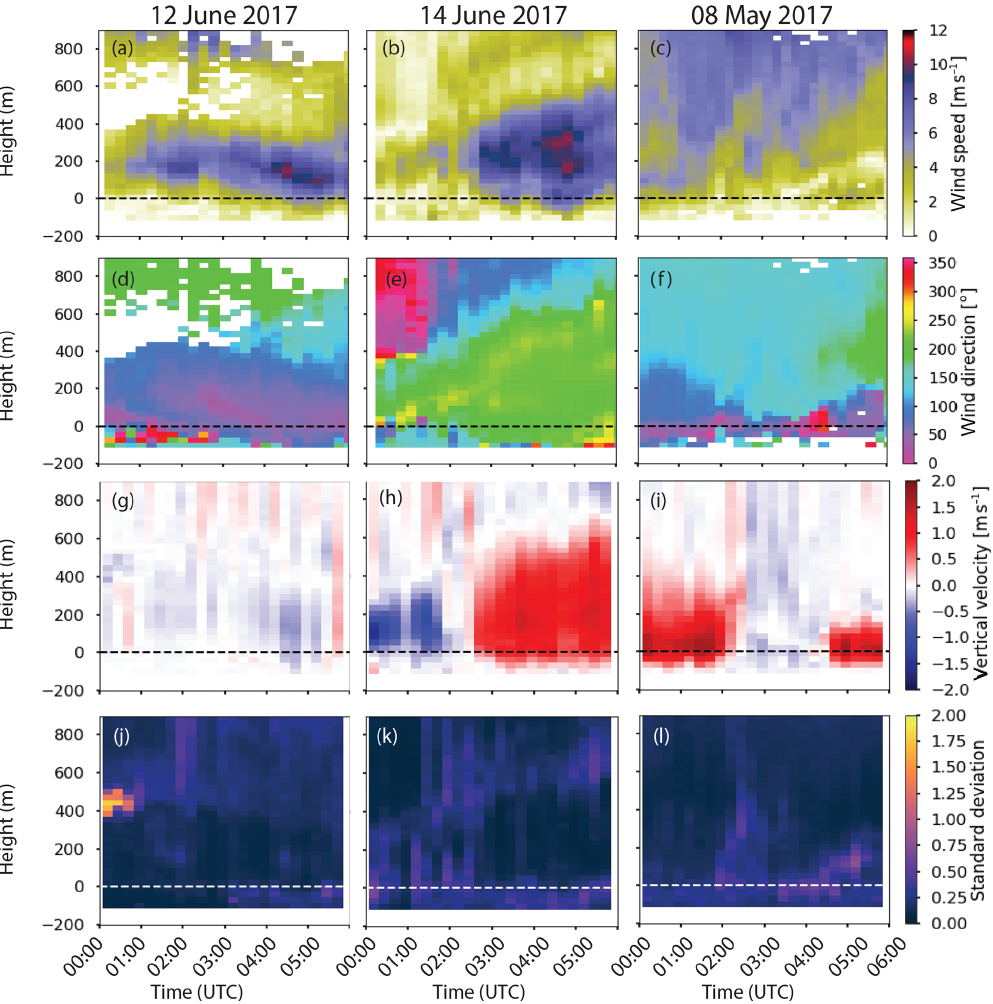
Figure 5. Time–height plots of three nights observed by the CLAMPS system. The top row (a–c) shows wind speed derived from the 70 ◦ VAD scan, the second row (d–f) shows the wind directions from the VAD, the third row (g–i) shows 15min averages of vertical velocity derived from the CLAMPS vertical stare data, and the bottom row (j–l) shows the standard deviation from the averages. The left column shows data from 8 May 2017, the middle column data from 12 June 2017, and the right column data from 14 June 2017. The height axis is relative to the base of the wind turbine on the southwest ridge, which is a proxy for ridge